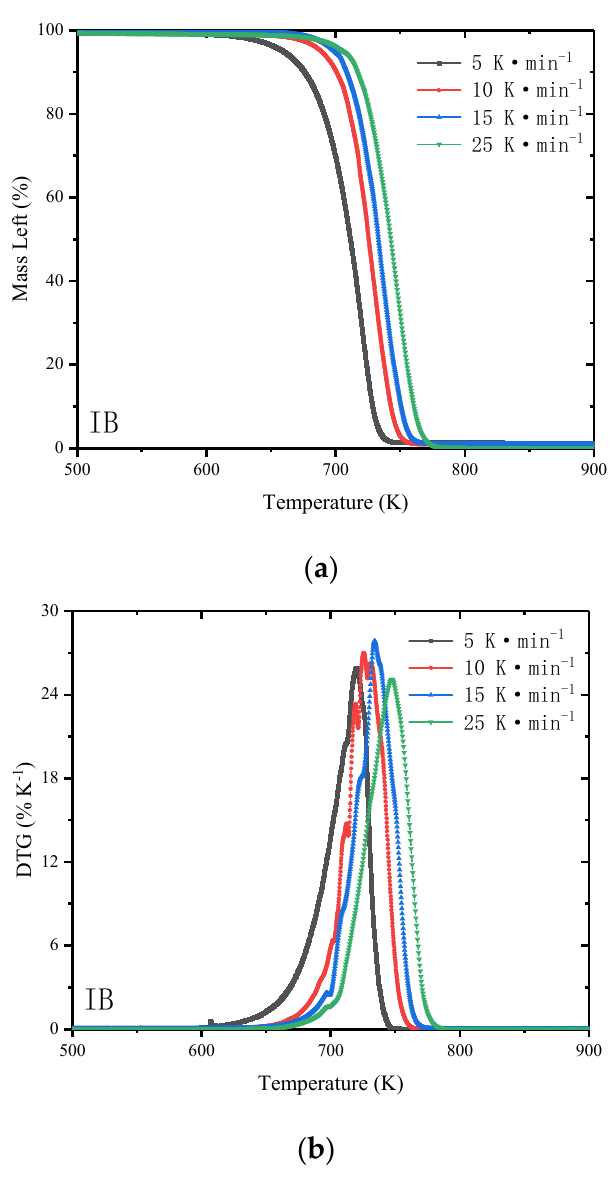
Figure 1. Thermogravimetric and Differential Thermogravimetry curves of infusion bag pyrolysis at different heating rates: ( a ) Thermogravimetric curves; ( b ) Differential Thermogravimetry curves.